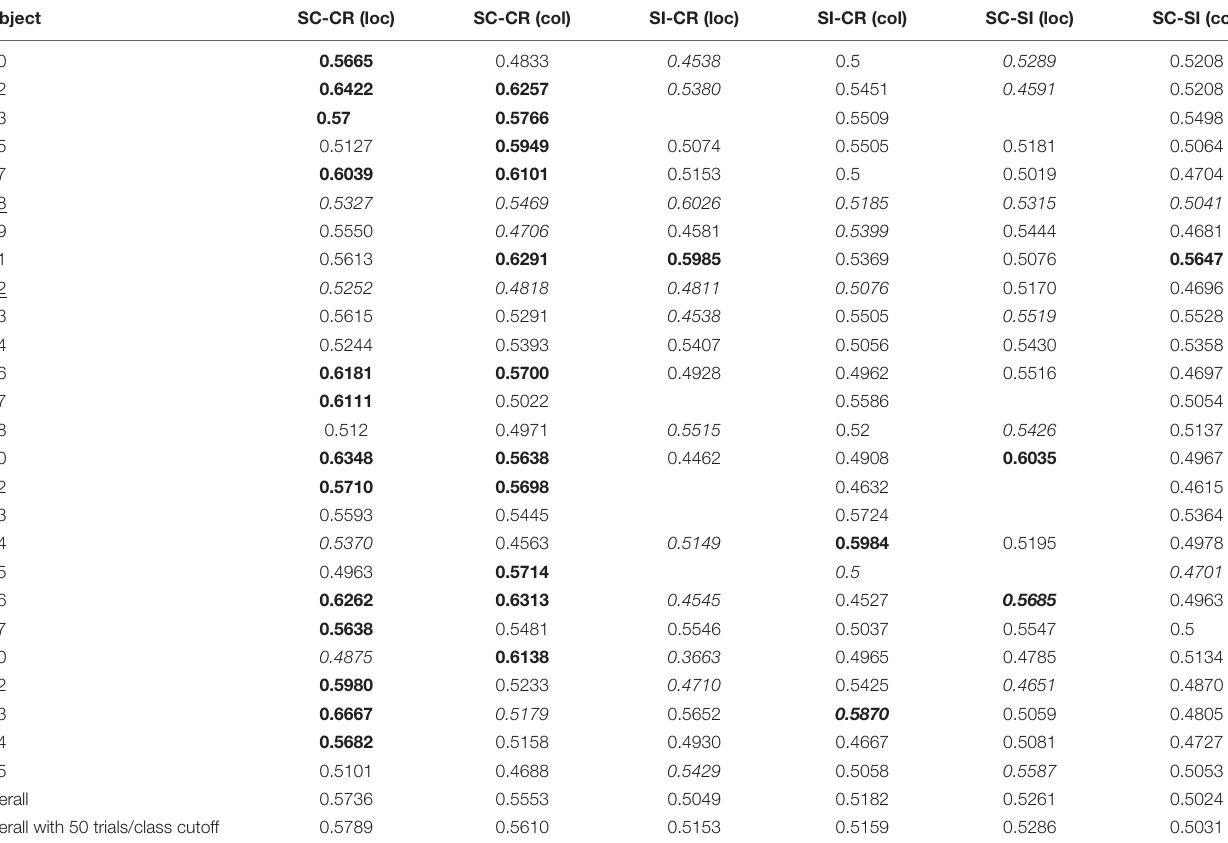
Overall accuracies given in the penultimate row are the accuracies over all trials from the relevant classes for subjects with 25 or more trials per class. Overall accuracies in the last row are computed over all trials from relevant classes for subjects with 50 or more trials per class. Bolded entries are significantly better than chance (p < 0.05). Results from subjects with less than 50 trials per condition are